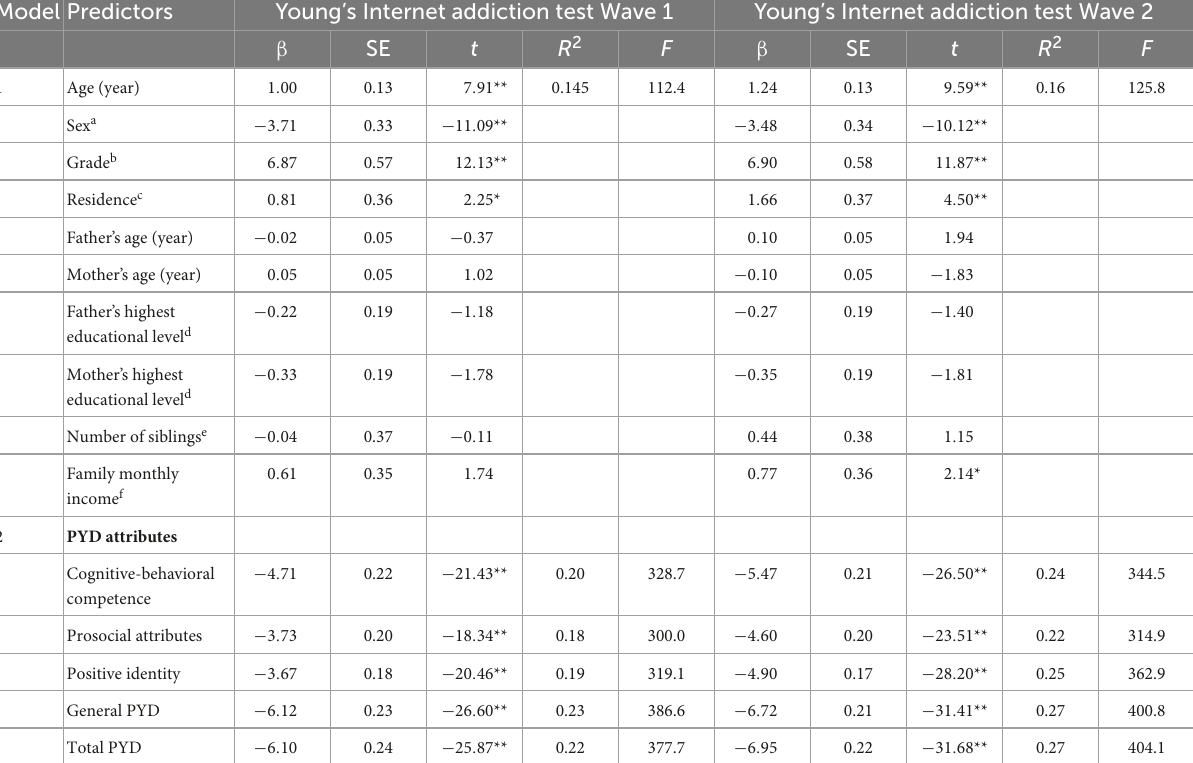
TABLE 3 Cross-sectional multiple regression analyses for Internet